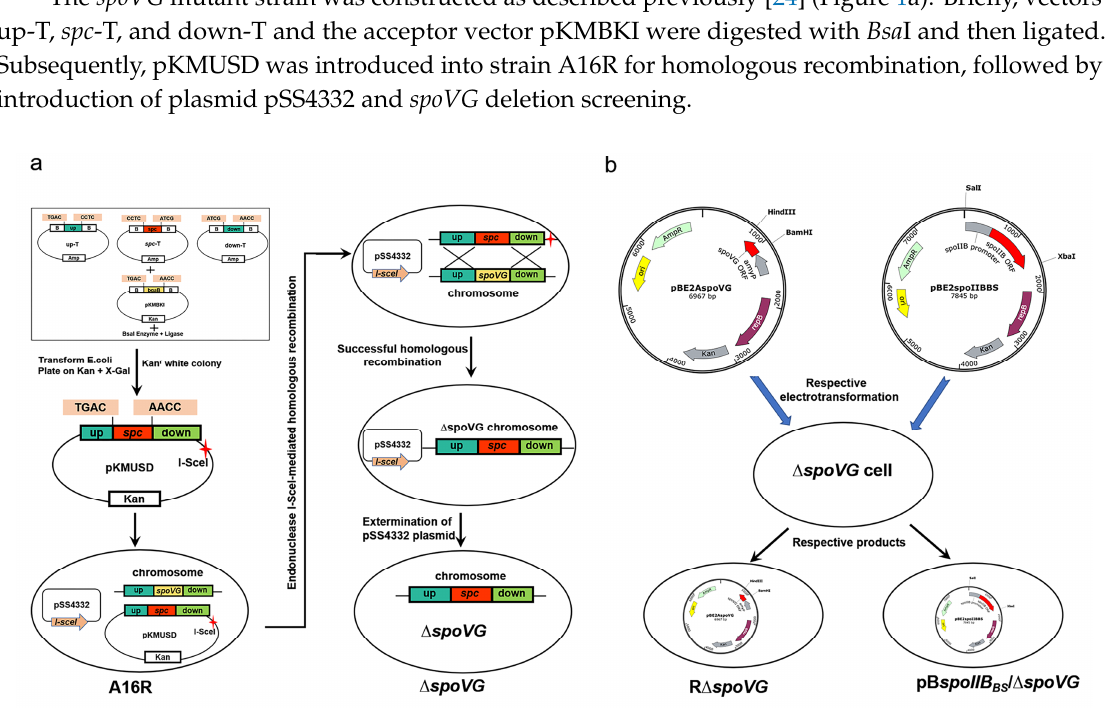
Figure 1. Schematic of construction of the B. anthracis Δ spoVG mutant and complemented strains. ( a )